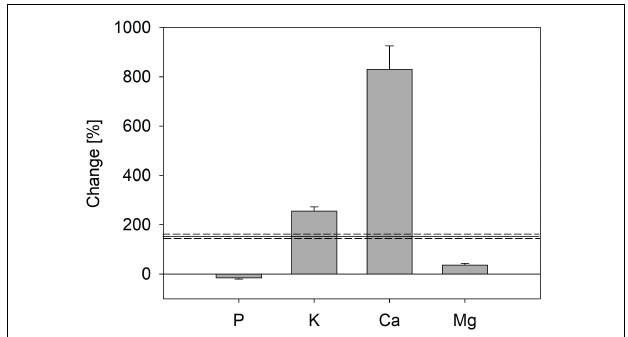
FIGURE 5 | Change of total nutrient mass in trees from the start (four saplings) until end of the experiment, including nutrients lost by leaf fall during both vegetation periods (trees of all treatments were pooled); error bars represent standard errors. Black line marks increase of total biomass during the experiment; dashed lines represent standard error.